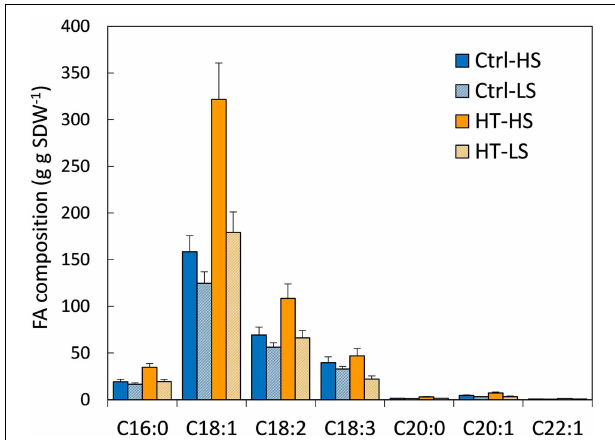
FIGURE 1 | FA composition (mg g SDW − 1 ) under the 4 treatments. Ctrl-T, Control temperature; HT, High temperature; HS, High sulfur; LS, Low sulfur. Bars denote s.e. C16:0 (palmitic acid), C18:1 (oleic acid), C18:2 (linoleic acid), C18:3 (linolenic acid), C20:0 (arachidic acid), C20:1 (gadoleic acid), C22:1 (erucic acid). Vertical bars are standard errors. Statistical effects are given in Supplemental Data Table 1.